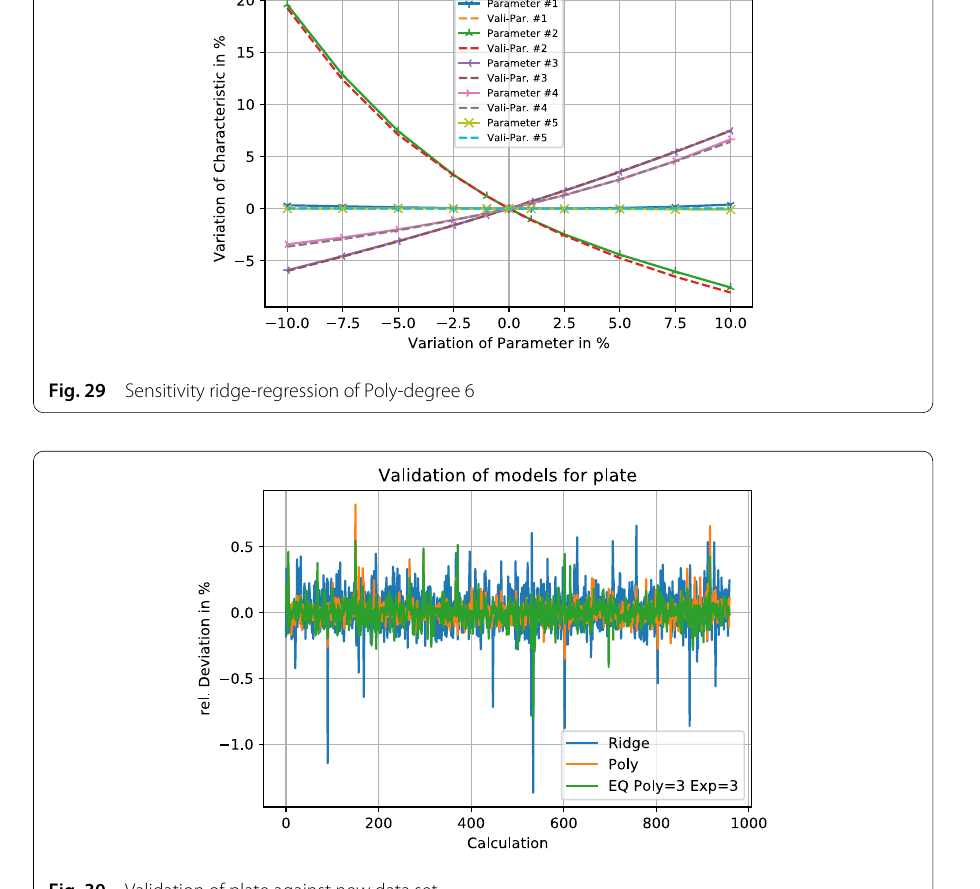
suppressed by the Ridge-regression compared to the fifth-order polynomial model of Fig. 28, left